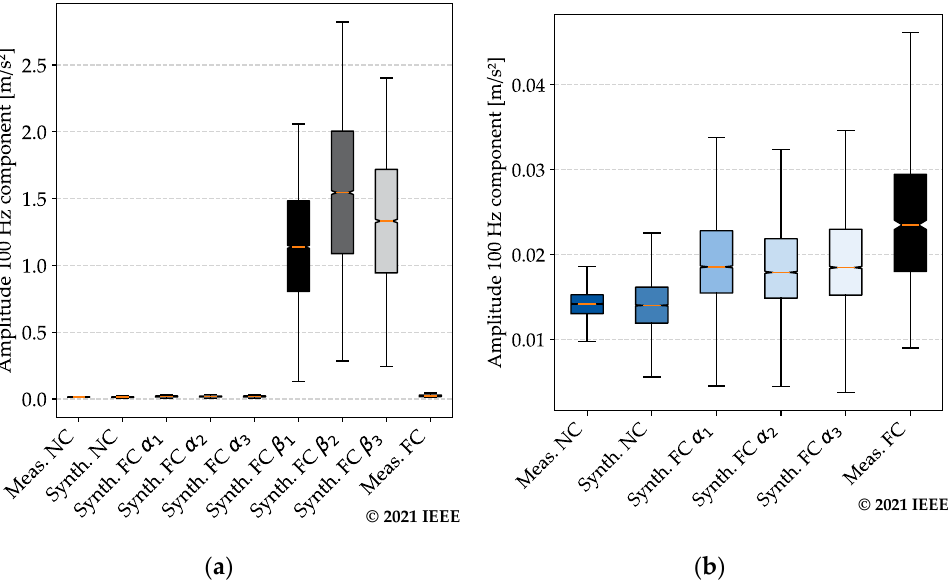
Figure 13. ( a ) Distribution of the measurements and synthetic data. ( b ) Distribution of the measurements and synthetic data except synthetic abnormal-condition data created with β 1 , β 2 , and β 3 [25]. Table 1. Percentage deviation of characteristic values of the box plots from the corresponding box plot values of the abnormal-condition measurements